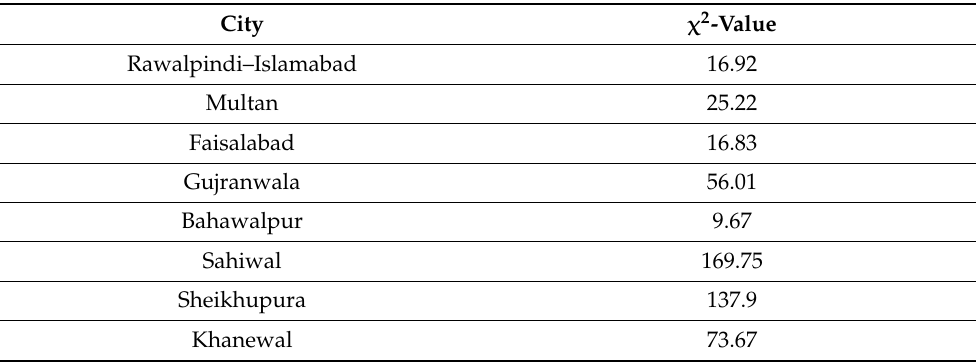
Table 9. Result of McNemar